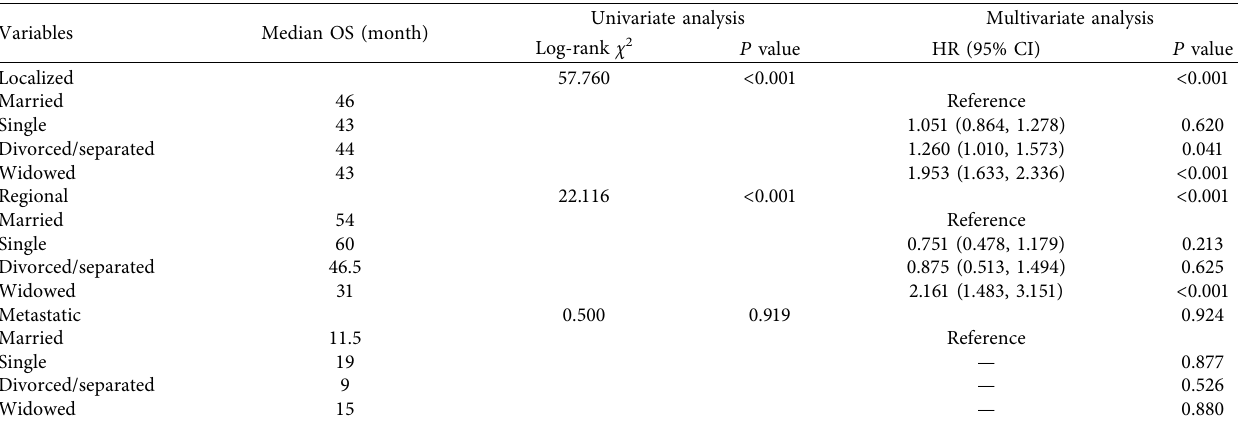
Table 7: Univariate and multivariate analysis for evaluating the influence of marital status on CCS according to SEER